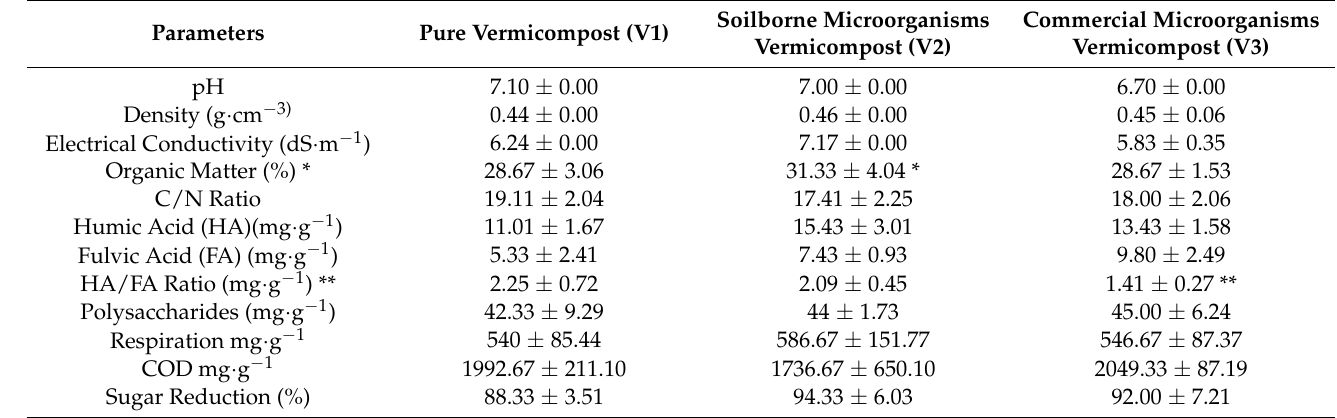
Table 2. Analysis of the chemical parameters evaluated in each treatment with three replicates (mean ± standard